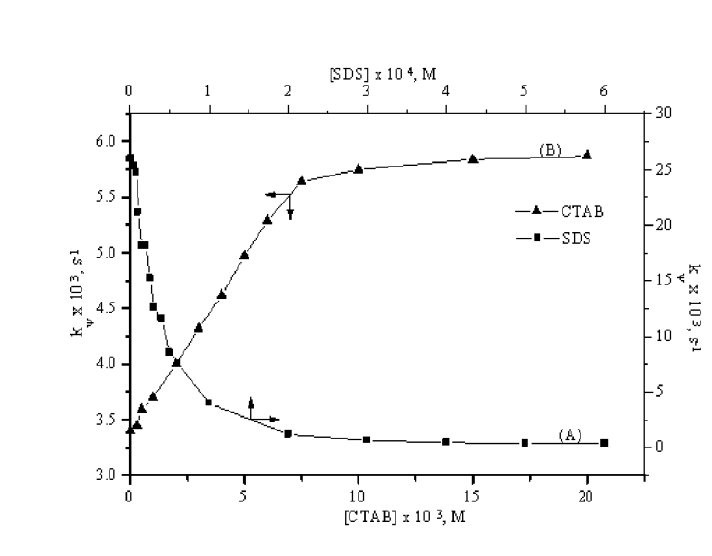
Figure 2 Dependence of the rate constant ( k inhibited reaction of RH + with OH - ; (B): CTAB catalysed reaction of RH + with OH - . The overall catalysis factor k rel+ (= k experimental data the kinetic CMC values were found to be 7.5 ×10 -3 M for CTAB and 1×10 -5 M for SDS